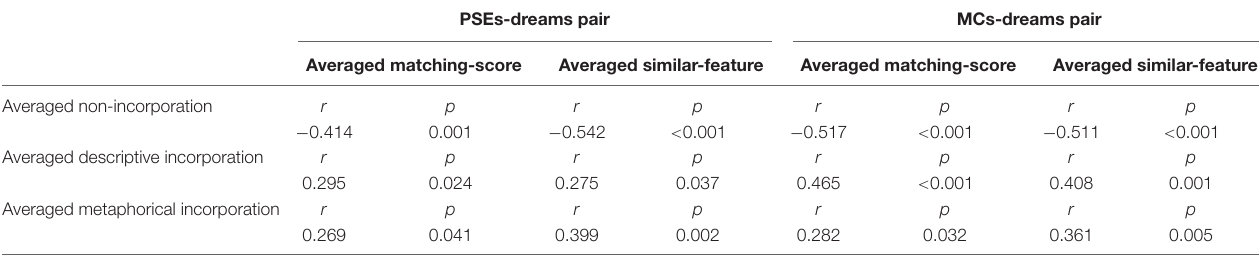
TABLE 3 | The correlation between the self-ratings and the external-ratings a . PSEs-dreams pair MCs-dreams